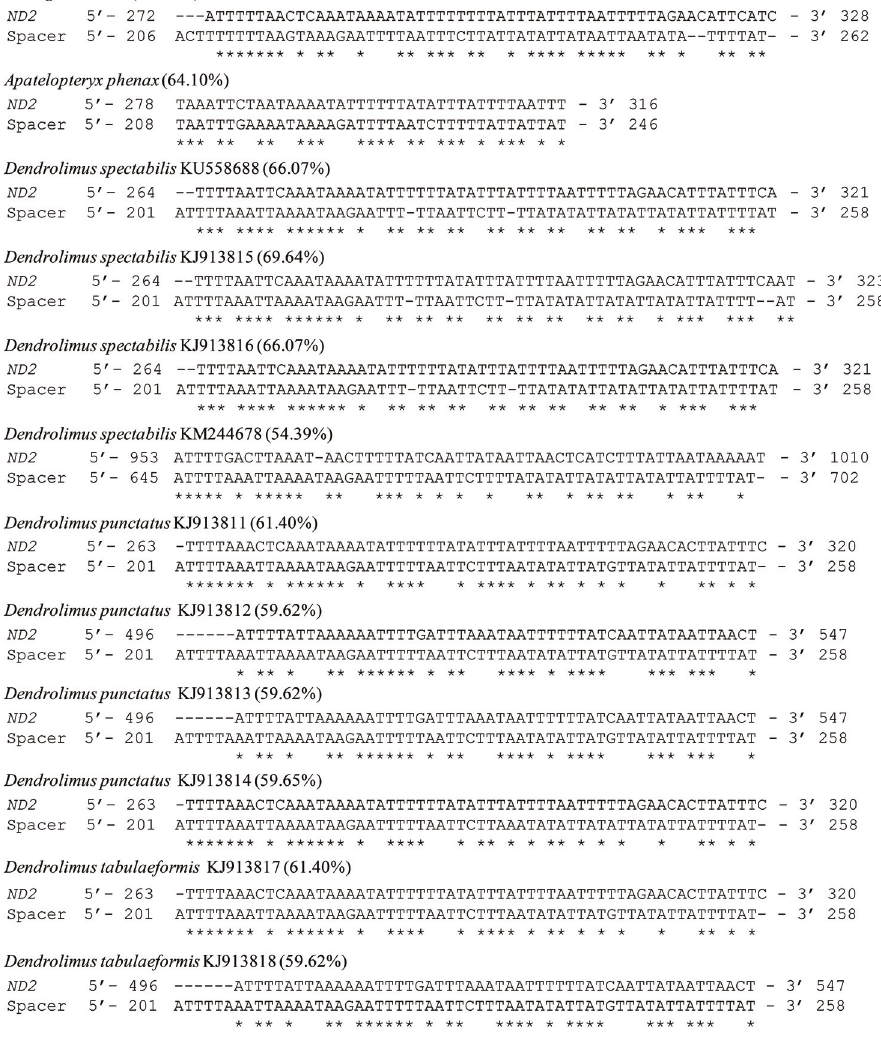
Figure 3 - Alignment of the spacer sequence (located between trnQ and ND2 ) and the neighboring partial ND2 of Lasiocampoidea, including Kunugia undans .Asterisksindicateconsensussequencesinthealignment.Sequencehomologybetweenthespacerand ND2 isshownintheparenthesesnexttothe species name and GenBank accession numbers of species represented by more than one mitogenome sequences. The beginning and end nucleotide posi- tions of the sequences are indicated.